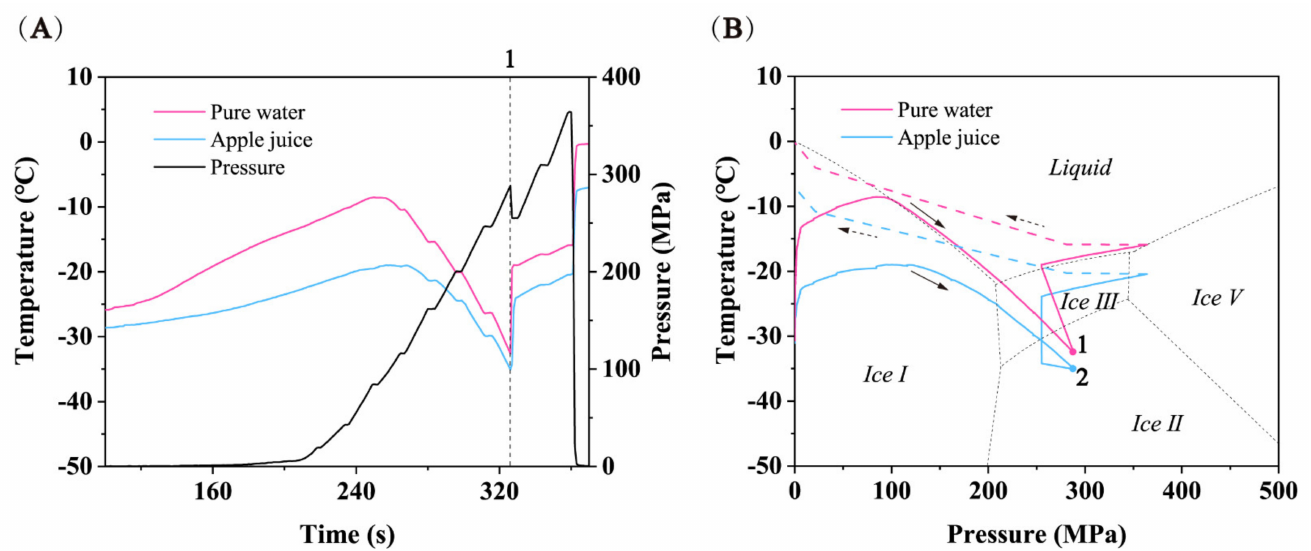
Figure 5. Temperature and pressure paths of frozen inoculated SSPS cooled by 20% sodium chlo- ride solution. ( A ) Temperature and pressure curves over time. ( B ) Temperature-pressure profile superimposed on the phase diagram of water. (—) pressure boost process, (—) pressure relief